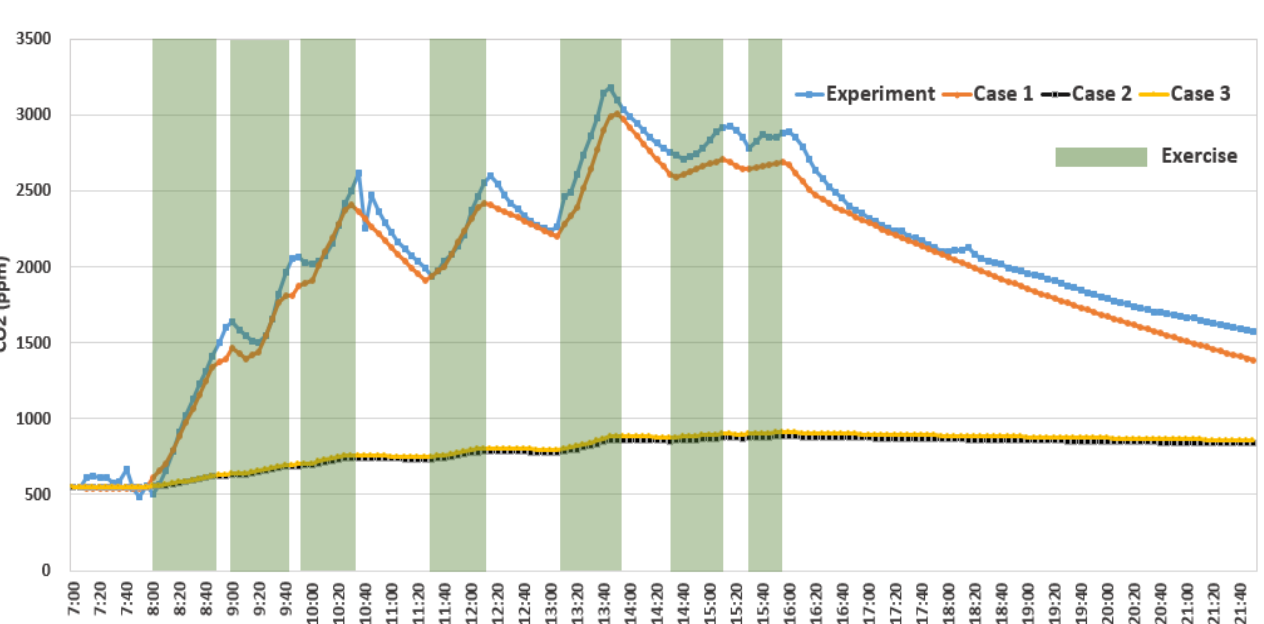
Table 8. Root mean square error (RMSE) and mean accuracy percentage error (MAPE) of the CONTAM simulation results of the CO 2 concentration in D Elementary School.